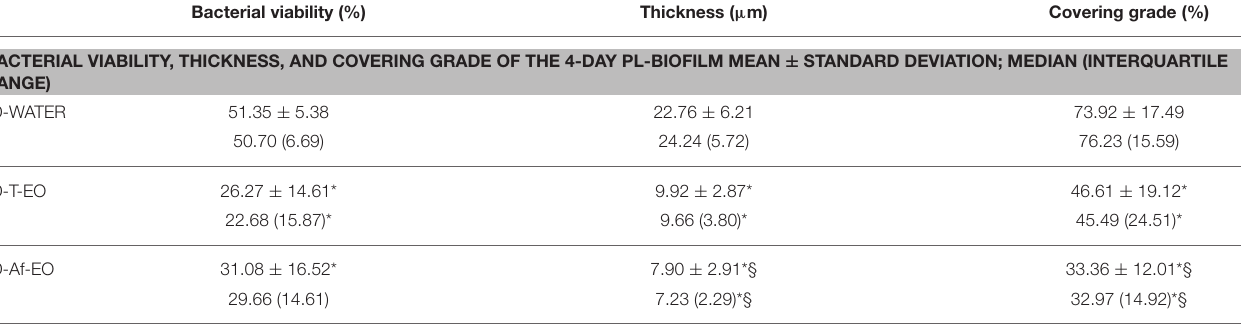
TABLE 2 | Bacterial viability, thickness, and covering grade of the PL-biofilm after 4 days of applying the three different rising protocols. Bacterial viability (%) Thickness ( µ m) Covering grade (%) BACTERIAL VIABILITY, THICKNESS, AND COVERING GRADE OF THE 4-DAY PL-BIOFILM MEAN ± STANDARD DEVIATION; MEDIAN (INTERQUARTILE